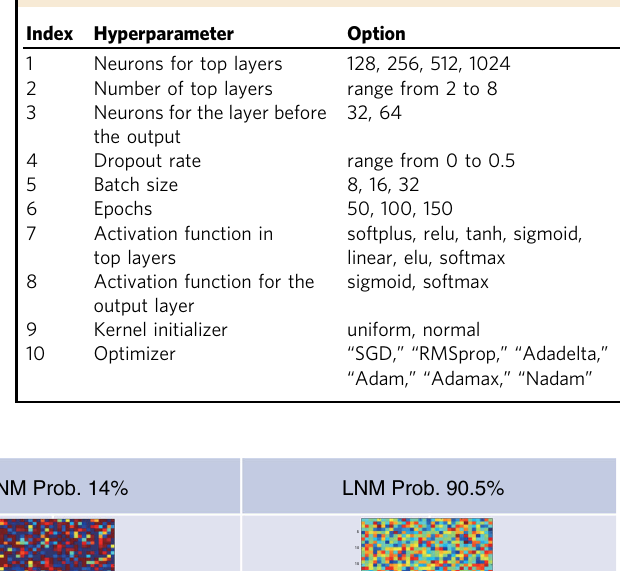
Table 4 Hyperparameter need to be optimized in model